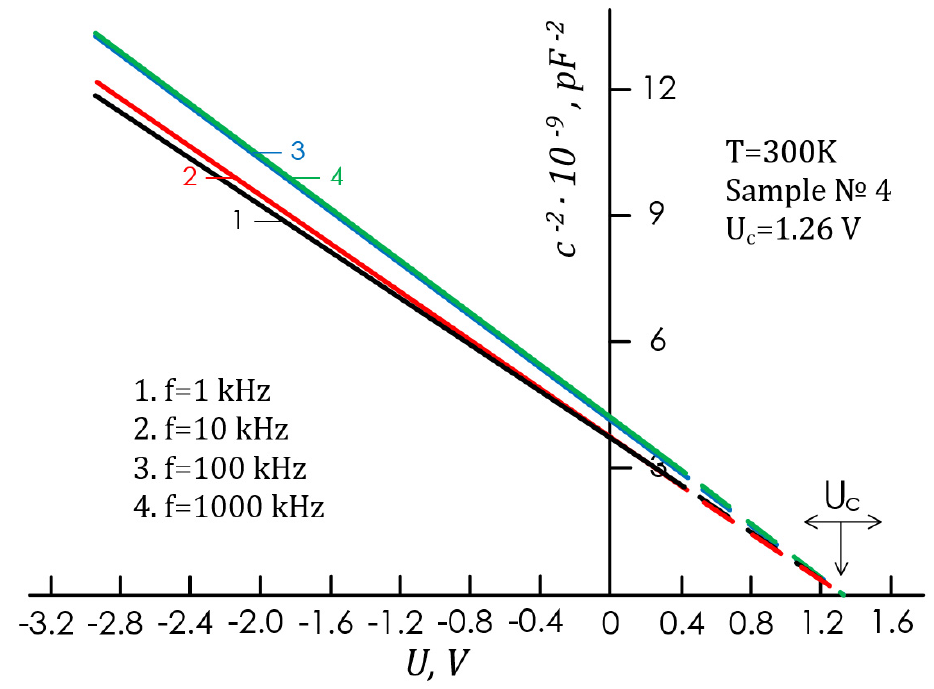
Figure 4. Differential capacitance dependence on the bias voltage for Au-Pd-n-GaP structures (Sample No. 4, β = 1.19) at different frequencies (f).